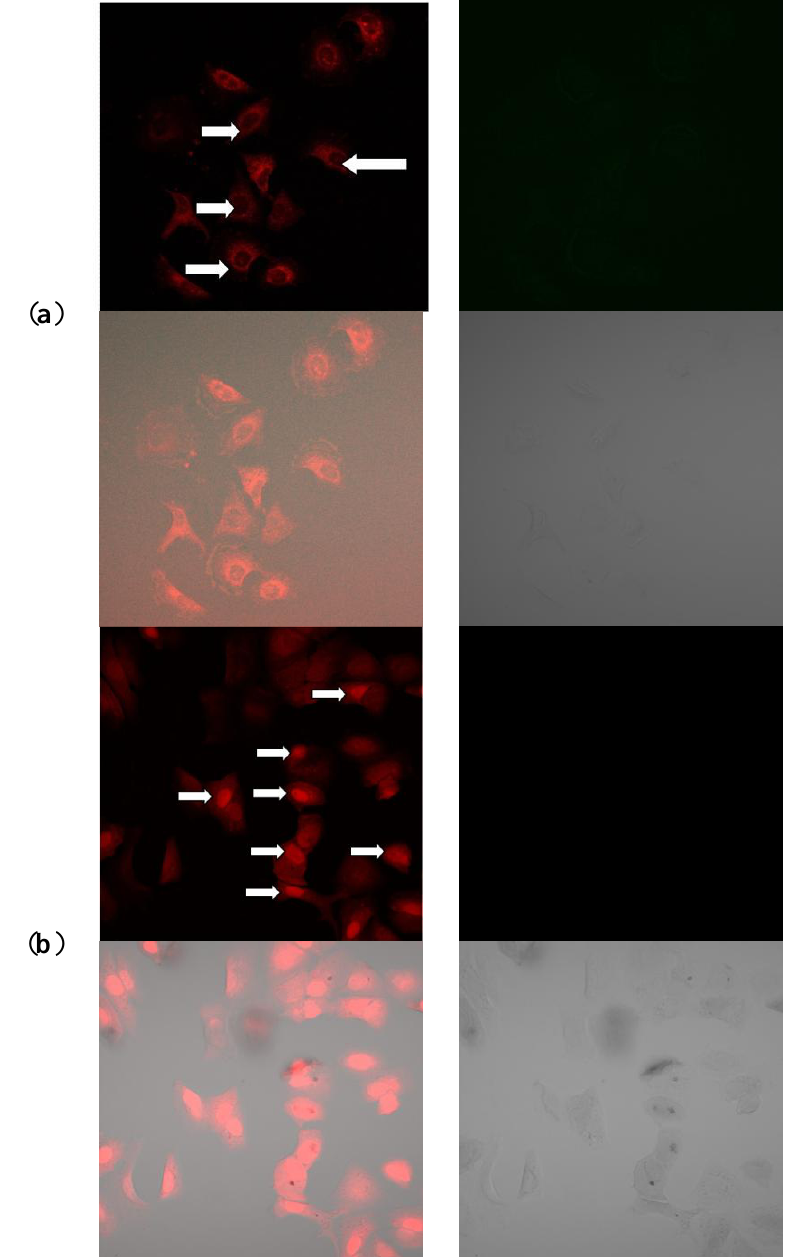
Figure 10. ( a ) Confocal microscopy images of doxorubicin-loaded CaCO uptake by MG 63 cells, Images are overlapped. Bright field image; ( b ) confocal microscopy images of free doxorubicin uptake by MG 63 cells. Images are overlapped Bright field